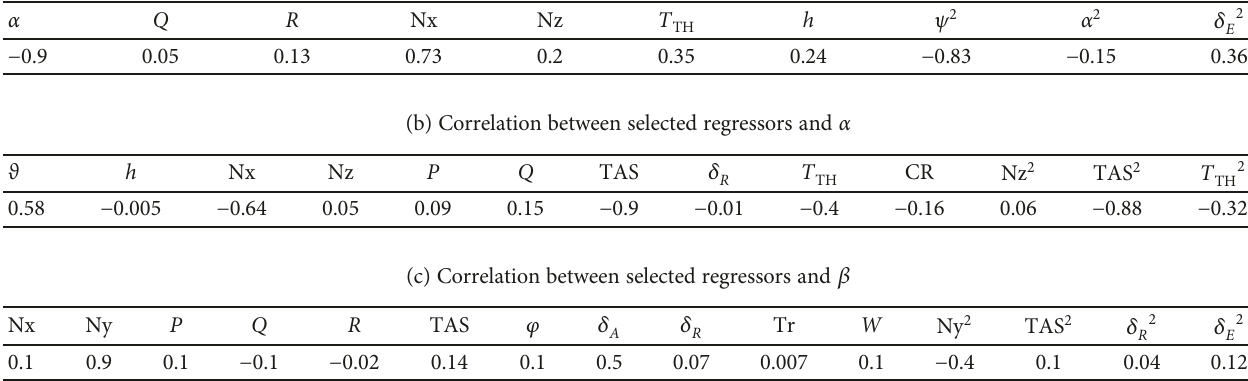
(a) Correlation between selected regressors and TAS